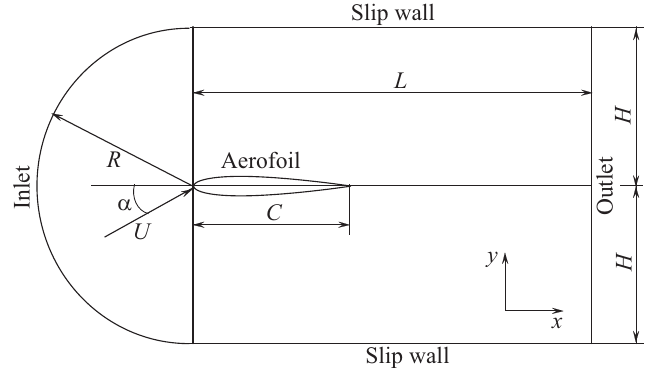
Figure 4. Geometry of the computational domain and boundary conditions. Free stream velocity corresponding to the Reynolds number and degree of turbulence (about 5%) is specified on the inlet boundary. Top and bottom boundaries are treated as free-slip walls. No-slip and no-penetration boundary conditions are applied to the airfoil. Non-reflecting boundary conditions are used on the outlet boundary. Periodic boundary conditions are used in the spanwise